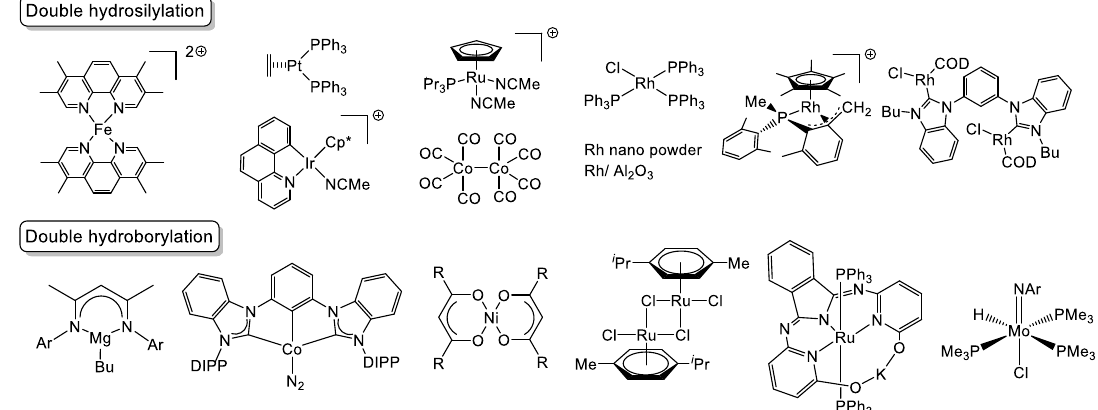
Scheme 1. Double hydrosilylation, double hydroborylation, and dihydroborylsilylation of organonitriles. Figure 1. Metal catalysts for double hydrosilylation and double hydroborylation of organonitriles. Molecules 2018 , 23 , x FOR PEER REVIEW 2 of 18